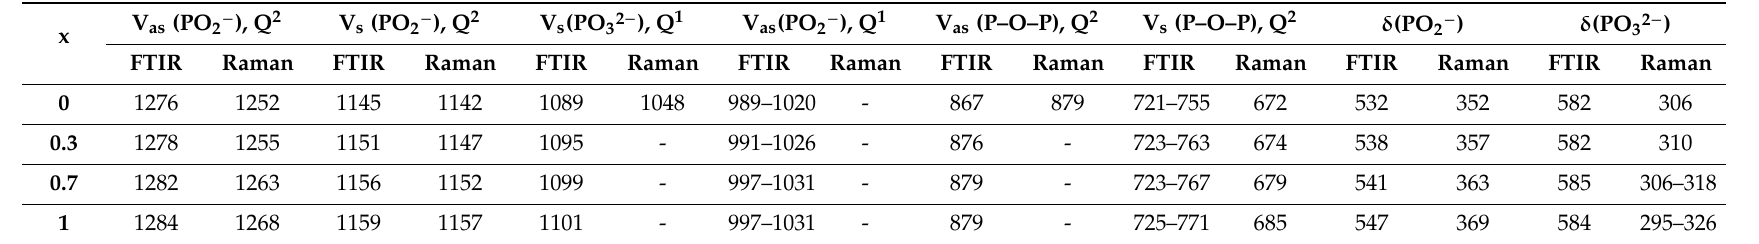
Table 2. Frequency ranges (cm − 1 ) and assignments of the Raman and infrared bands of the studied glasses.